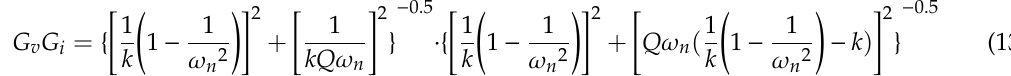
Figure 3. Current gain 𝐺 𝑖 according to load quality factor and 𝜔 𝑛 (K = 1, K = 0.2).